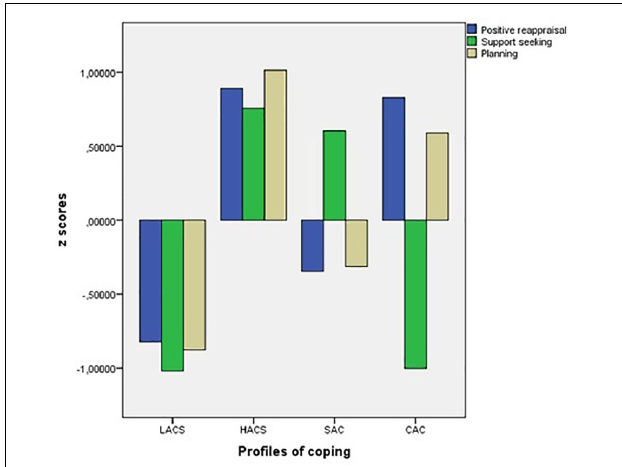
FIGURE 1 | Graphical representation of coping profiles (standardized scores). LACS: profile of low approach coping strategies; HACS: profile of high approach coping strategies; SAC: profile with a prevalence of social approach coping strategies; CAC: profile with a prevalence of cognitive approach coping strategies.